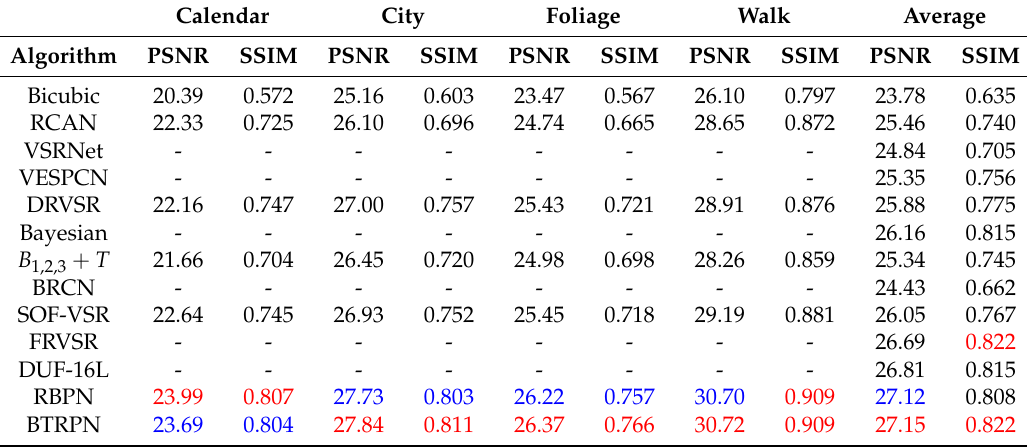
Figure 10. Qualitative comparison on the foliage clip for 4 × video SR. Table 8. Quantitative comparison on the VID4 dataset for 4 × video SR. Red and blue indicate the best and second-best performance, respectively.